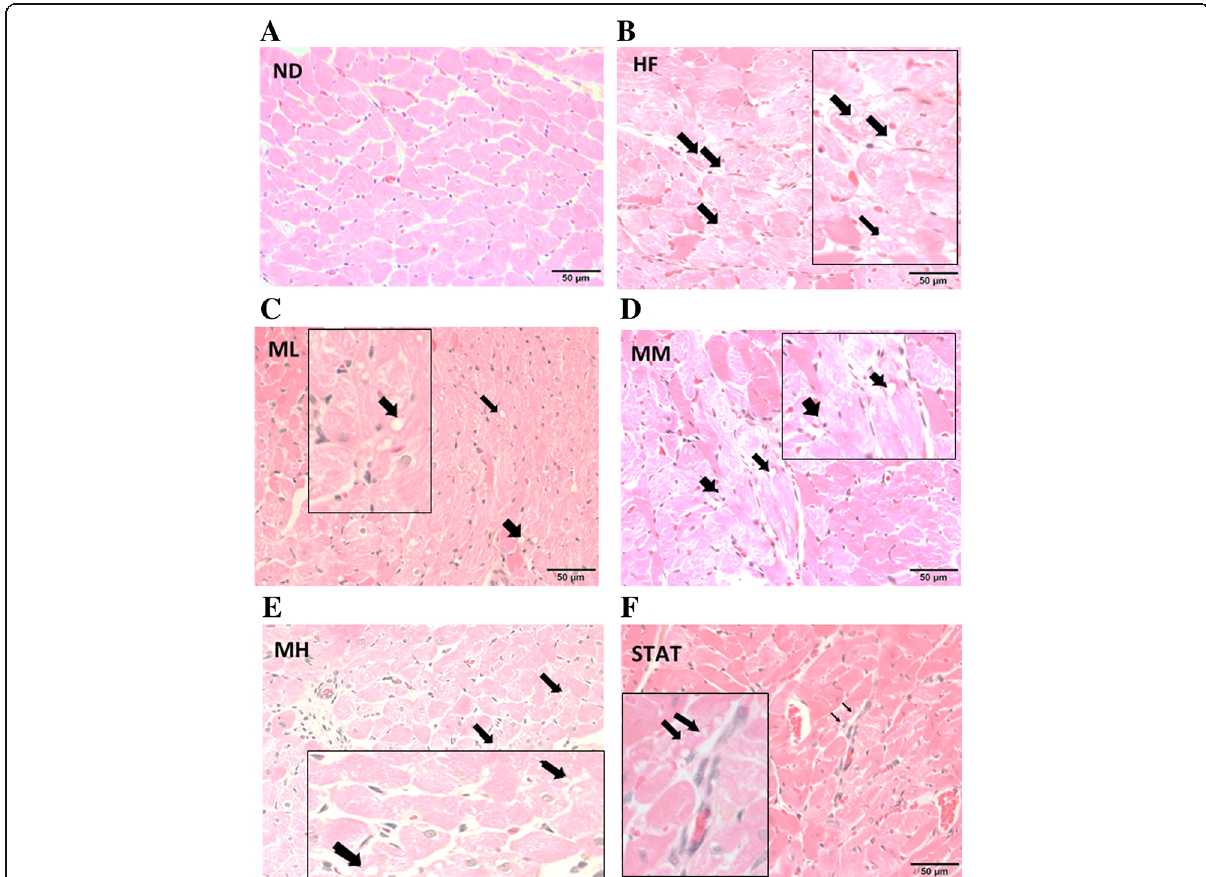
Fig. 2 Light microscopic images of H&E-stained transverse-sections of cardiac tissues of rats after 12 weeks of Maoberry. For comparison, images showed different fat droplets in the different treatment groups (magnification ×100). a ND: rats fed a standard diet, b HF: rats fed a high-fat diet with distilled water, c ML, d MM and e MH: rats fed a high-fat diet with Maoberry extract at 0.38, 0.76 and 1.52g/kg, respectively, f STAT: rats fed a high-fat diet with 10mg/kg simvastatin. Arrows represent fat droplets. Panels enlarge the area of pathological alterations (magnifiacation ×